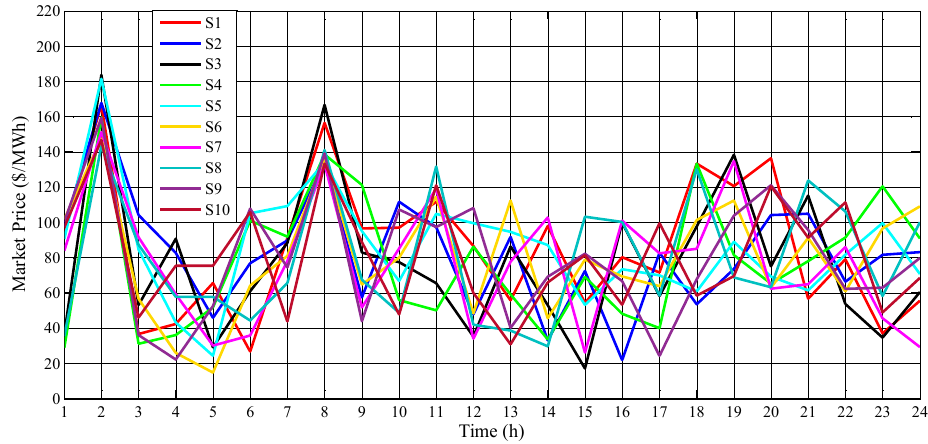
Figure 8. Real-Time Wholesale Electricity Market (RT WEM) prices for reduced scenarios.